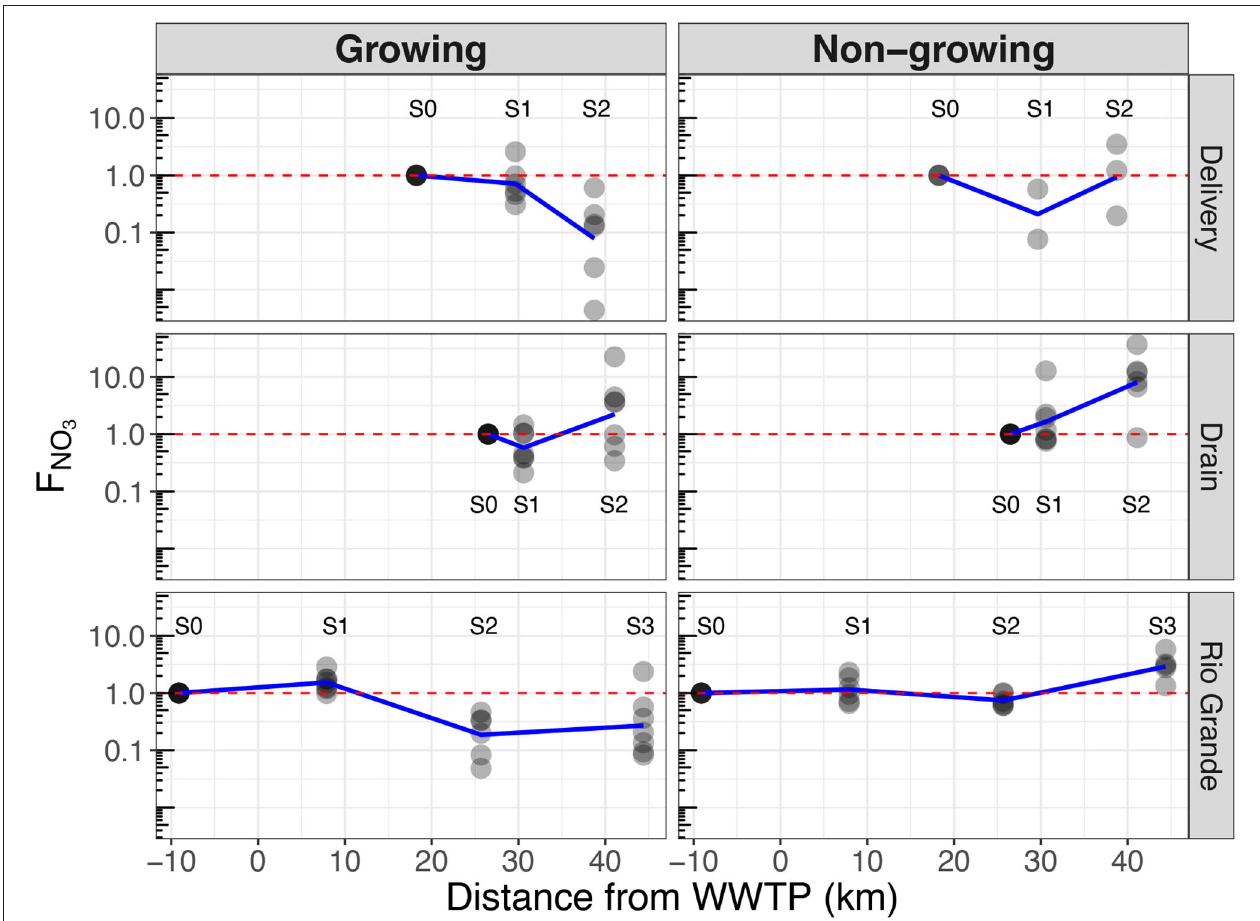
> 1) and sink ( F NO